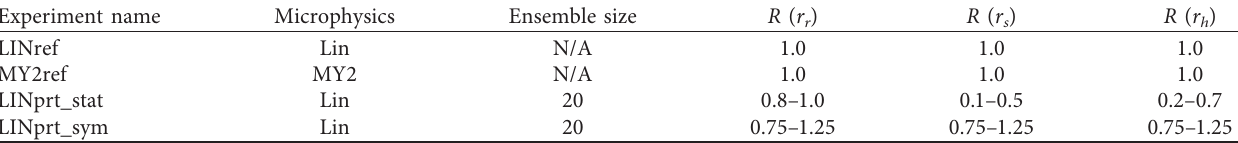
Table 1: Configurations of the idealized case.